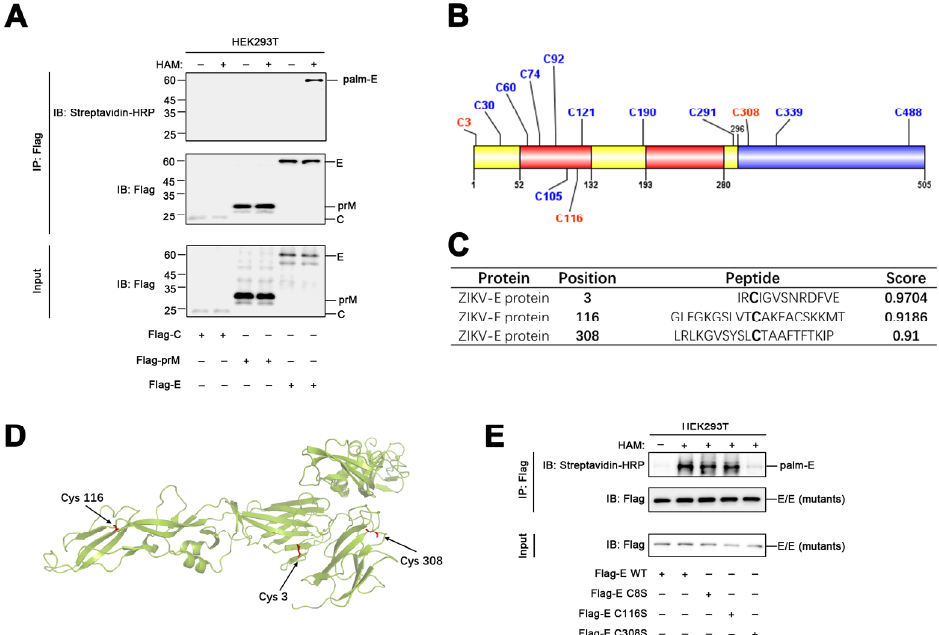
Figure 2. The envelope protein of ZIKV is palmitoylated at Cys308. ( A ) HEK293T cells were transfected with a plasmid encoding the ZIKV capsid (C), prMembrane (prM), and envelope (E) proteins for 24 h, lysed for ABE assays, and detected using immunoblotting with the indicated antibodies. ( B ) Schematic depicting all the 13 cysteine residues in the structure of the envelope protein. ( C ) Possible palmitoylation sites in the envelope protein of ZIKV were predicted using the GPS-Palm system. ( D ) The predicted cysteine residues are highlighted in the structure of the envelope protein.